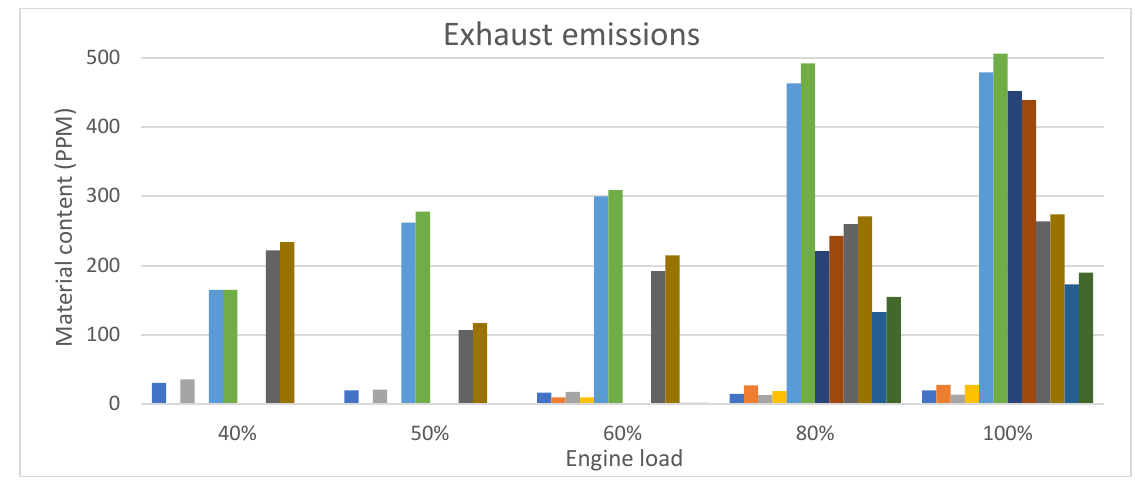
Figure 9. Different emissions of the engine. Table 7. Measured emission values.